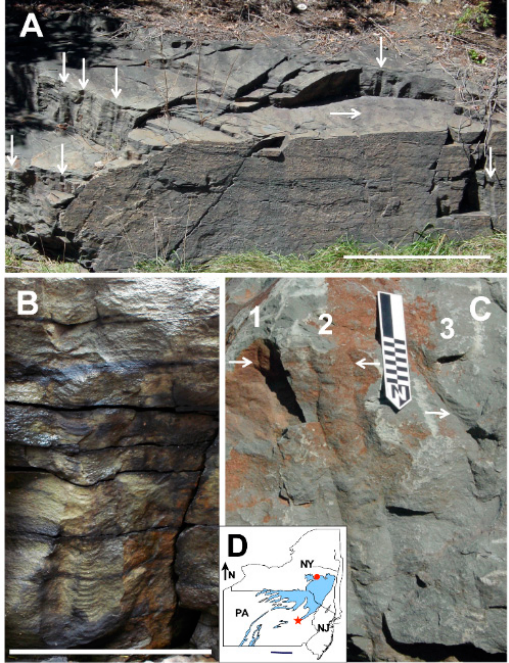
Figure 3. Vertical Catskill Magnafacies burrows. ( A ) Outcrop of the Towamensing Member of the Catskill Formation, near Harrity, Pennsylvania, which exposes vertical burrows associated with shell impressions of Archanodon catskillensis body fossils found at the same site. Most burrows at this site show well developed menisci. Vertical arrows indicate individual burrows oriented perpendicular to bedding and seen in longitudinal view. Horizontal arrow indicates a cluster of about 15 burrows oriented perpendicular to bedding seen on a bedding surface in cross-sectional view. Scale bar represents 2 m. From Figure 6D of Chamberlain and Chamberlain 2007 [5]; ( B ) Single Harrity burrow with concave up menisci in the burrow core and down-turned bedding planes in the burrow halo. Scale bar represents 25 cm; ( C ) Three vertical burrows (numbered) in the Oneonta Formation, Jewett Quarry, Jewett, New York. Burrows do not show well developed menisci, although some are present (arrows). These burrows are not associated with A. catskillensis body fossils. Small scale divisions represent 1 cm. From Figure 6C of Chamberlain and Chamberlain 2007 [5]. ( D ) Map of New York State (NY), Pennsylvania (PA), and New Jersey (NJ) showing location of the Harrity, PA, outcrop (red star), and the Jewett, NY, quarry site (red dot). Blue shading shows the outcrop area of terrestrial Catskill facies of Johnson and Friedman [30]. Table 1. Physical, environmental, and temporal characteristics of burrows constructed by Archanodon catskillensis . After Figure 13 of Chamberlain and Chamberlain [29].